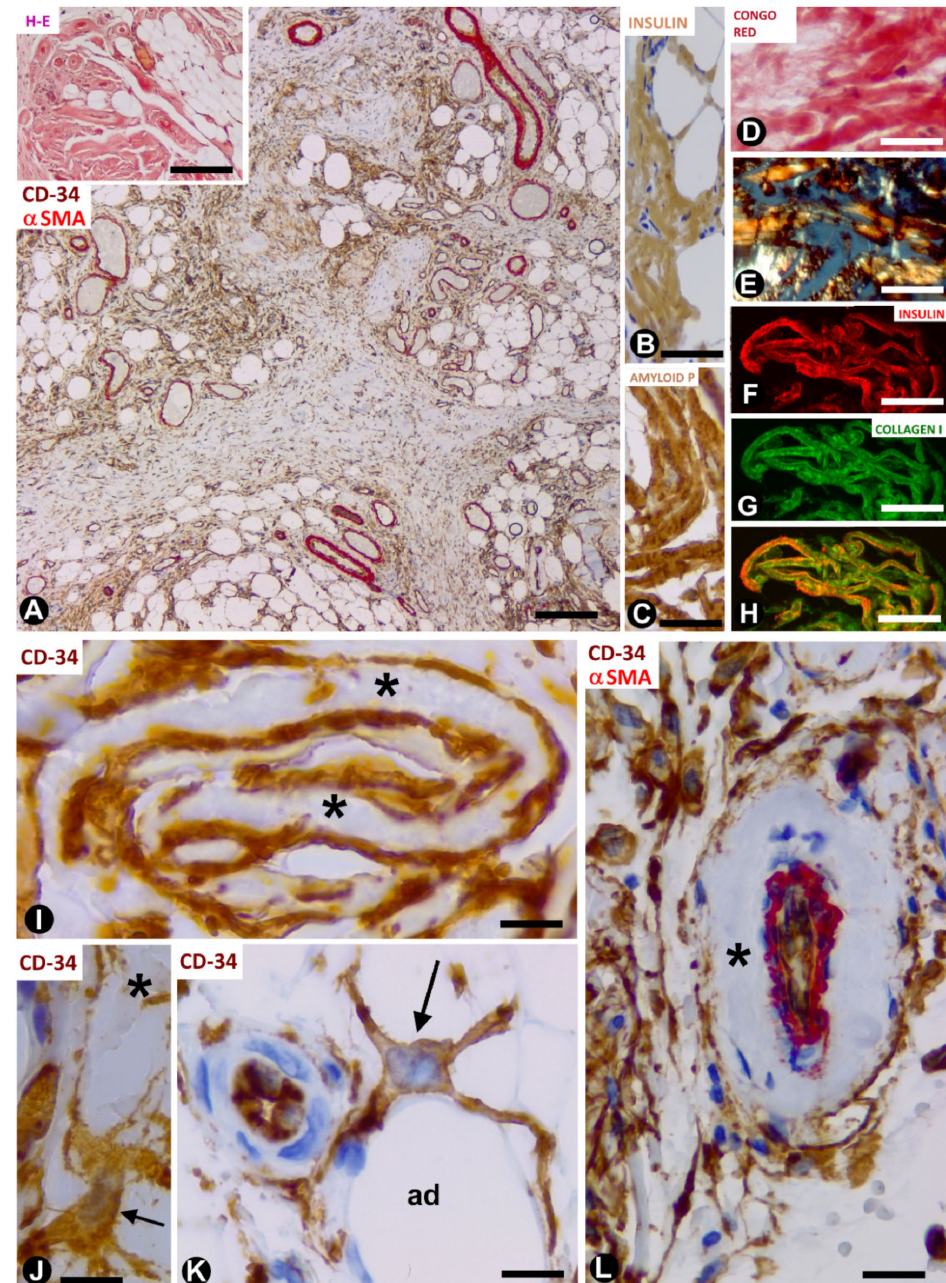
Figure 3. TCs / CD34 + SCs in adipose tissue with iatrogenic insulin-amyloid type amyloidosis. ( A ): numerous TCs / CD34 + SCs in adipose lobules are arranged between fibrous tracts. Double immunochemistry labelling for CD34 (brown) and α SMA (red). Insert: a nodule with haematoxylin staining. ( B – H ): amyloid deposits showing immunochemistry labelling for insulin ( B ) and amyloid P ( C ), Congo red positivity ( D ) with yellow-green birefringence under polarised light ( E ), and the colocalisation of insulin and collagen ( I) (( F ): insulin—red; ( G ): collagen ( I )—green and ( H ): the colocation of both). ( I ): projections of TCs / CD34 + SCs (brown) around folded amyloid deposits (asterisks). ( J – L ): TCs / CD34 + SCs (brown, arrows) with projections around an amyloid deposit (( J ), asterisk), adipocytes (( K ), ad) and amyloid components in the adventitia (asterisk) of a vessel with double immunochemistry labelling for CD34 (brown) and α SMA (red). Bar: (( A ) and insert): 160 µ m; ( B – H ): 50 µ m; ( I – K ): 20 µ m; ( L ): 60 µ